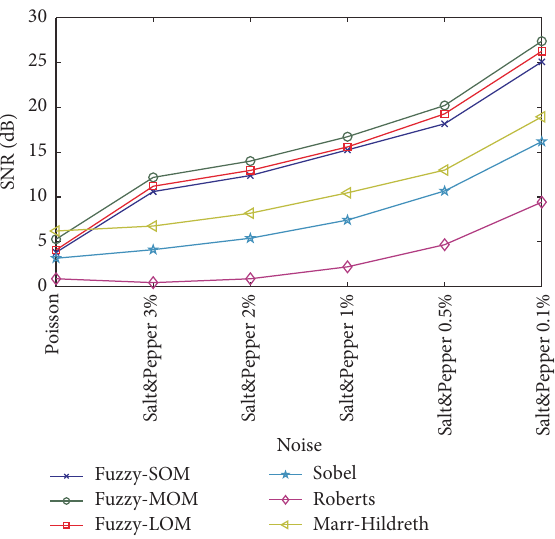
Figure 11: SNR in dB using different artificial noise (cameraman’s image as